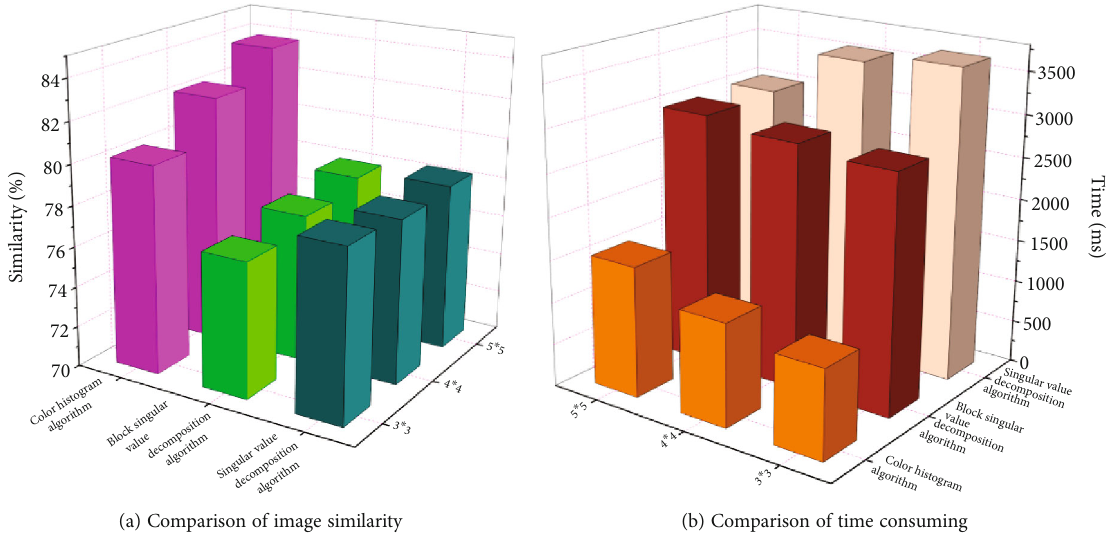
Figure 6: Comparison between original image and enhanced